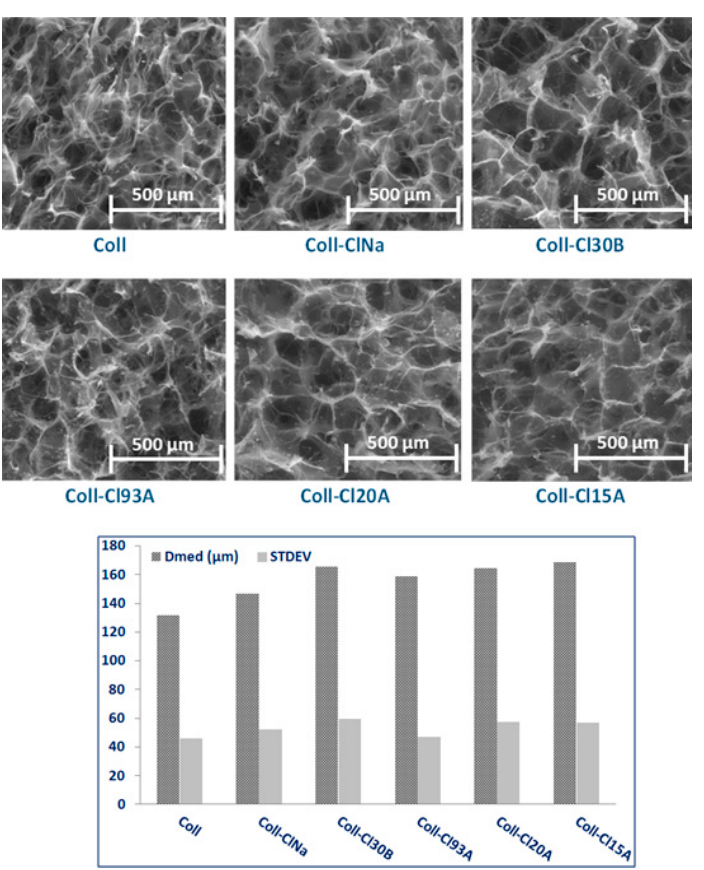
Figure 3. SEM images of collagen/clay composite biomaterials (250×) and calculated average pore diameter with standard deviation.